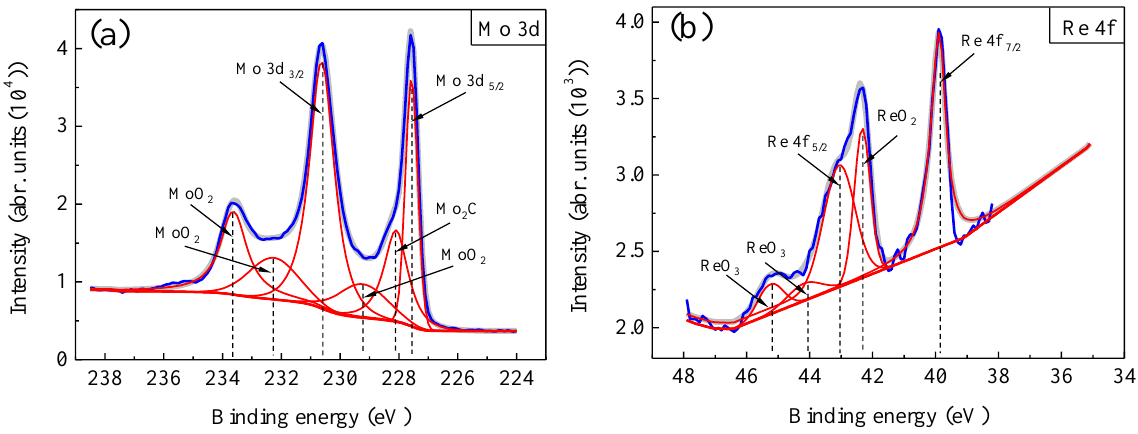
Figure 13. XPS results of Mo and Re elements: peak-fitting results of ( a ) Mo 3d and ( b ) Re 4f. The red curve indicates the spectrum of the phase used for the fitting, the blue curve indicates the fitted Mo3d spectrum and the gray curve indicates the original Mo3d spectrum.